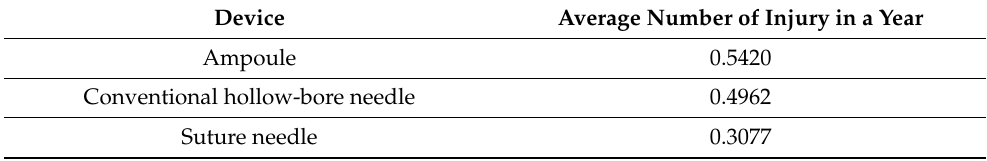
Table 5. Expected (average) number of injuries in a year per person by